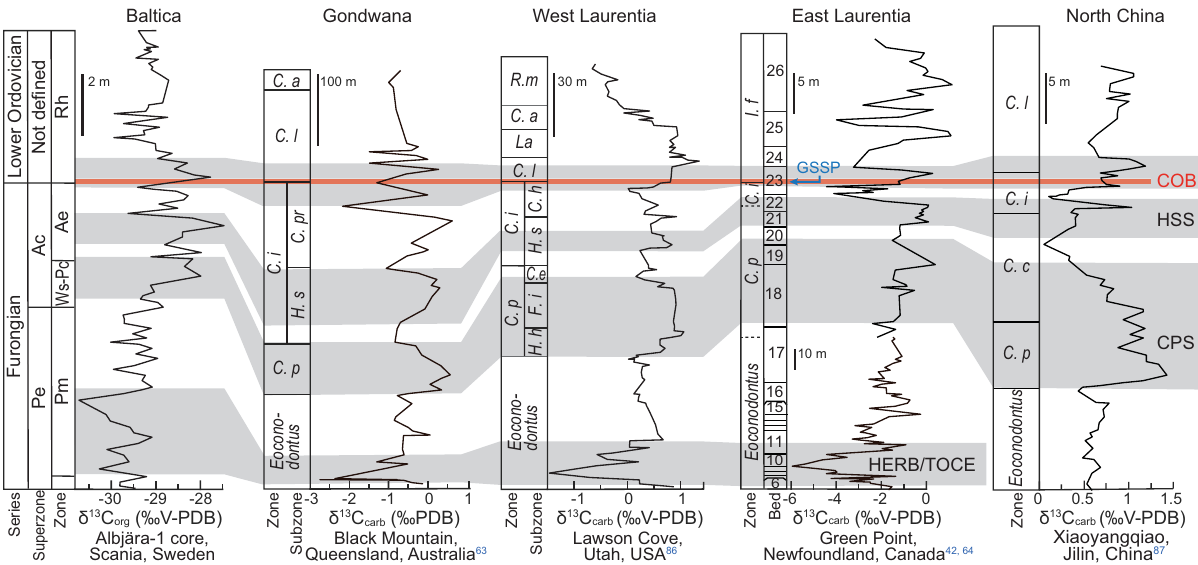
Fig. 3 Global biozone and carbon isotope correlations across the Cambrian – Ordovician boundary. Carbon isotope excursions include the Hellnmaria-Red Tops Boundary Event/the Top of Cambrian Excursion (HERB/TOCE; refs. 8,52,53,63 – 67,86 ), Hirsutodontus simplex spike (HSS; refs. 8,63,87 ), Cordylodus proavus spike (CPS; refs. 8,63,87 ) and excursion at the Cambrian – Ordovician boundary (COB; refs. 8,41,42 ). Based on these excursions, the Cambrian – Ordovician boundary can be con fi dently determined for the Albjära-1 well, which is in accordance with the biostratigraphic data at hand. Ac Acerocarina , Pe Peltura , Rh Rhabdinopora spp., Ae Acerocare ecorne , Ws – Pc Westergaardia scanica , Acerocarina granulata and Peltura costata , Pm Parabolina heres megalops ; I. f Iapetognathus fl uctivagus , R. m Rossodus manitouensis , C. a Cordylodus angulatus , La lapetognathus , C. l Cordylodus lindstromi , C. i Cordylodus intermedius , C. p Cordylodus proavus , C. pr Cordylodus prolindstromi, C. h Clavohamulus hintzei , H. s Hirsutodontus simplex , C. e Clavohamulus elongatus, F. i Fryxellodontus inornatus , H. h Hirsutodontus hirsutus